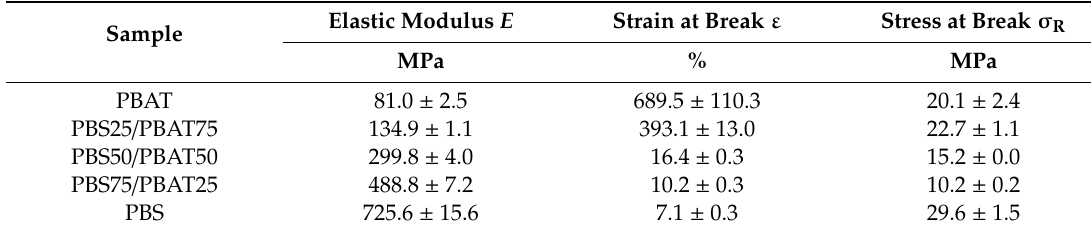
Table 4. Tensile properties of PBAT, PBS and their